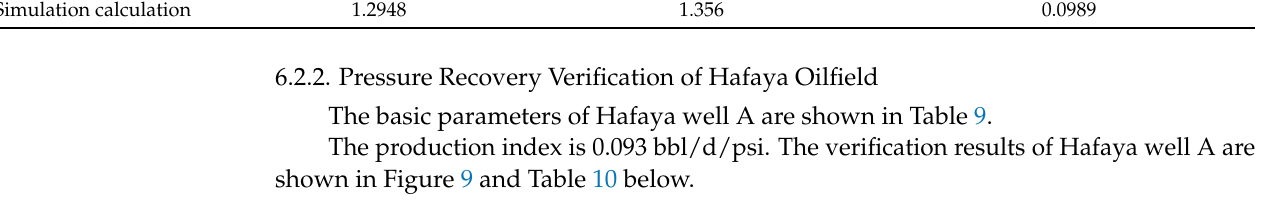
Figure 8. Comparison of pressure recovery simulation calculation results and test data.